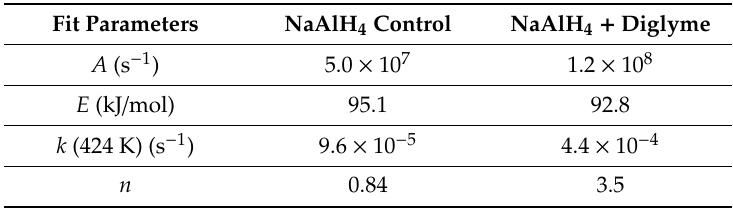
Figure 3. Fractional decomposition from step 2 for ( a ) NaAlH 4 control and ( b ) NaAlH 4 + diglyme. Table 2. Fit parameters from a A-E fit to the second step of desorption (fractional decomposition) of NaAlH 4 (control) and NaAlH 4 + diglyme.